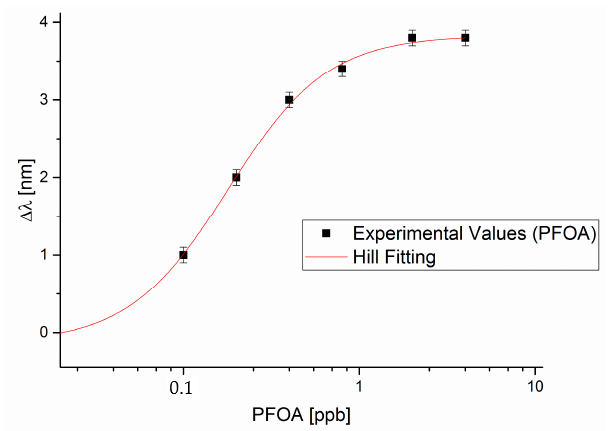
Figure 3. Plasmon resonance wavelength variation ( ∆λ ), with respect to the blank, versus the concentration of PFOA (ppb) and Hill fitting to the experimental values, in semi-log scale.